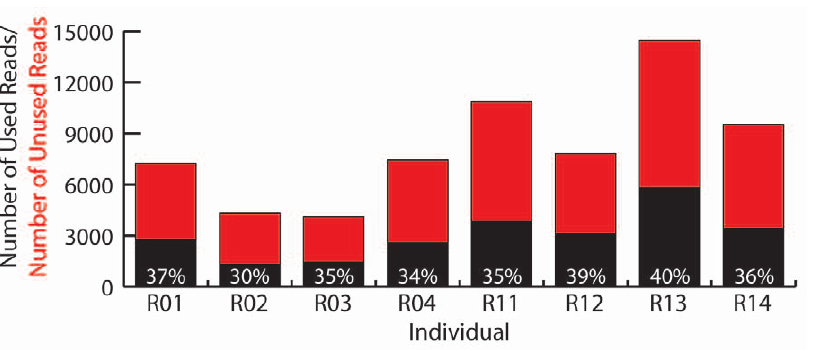
Figure 3. Number of reads per individual. Black portion of bars represents reads aligned to the reference; red portion accounts for unused reads. Percentage of reads used is shown in white text.